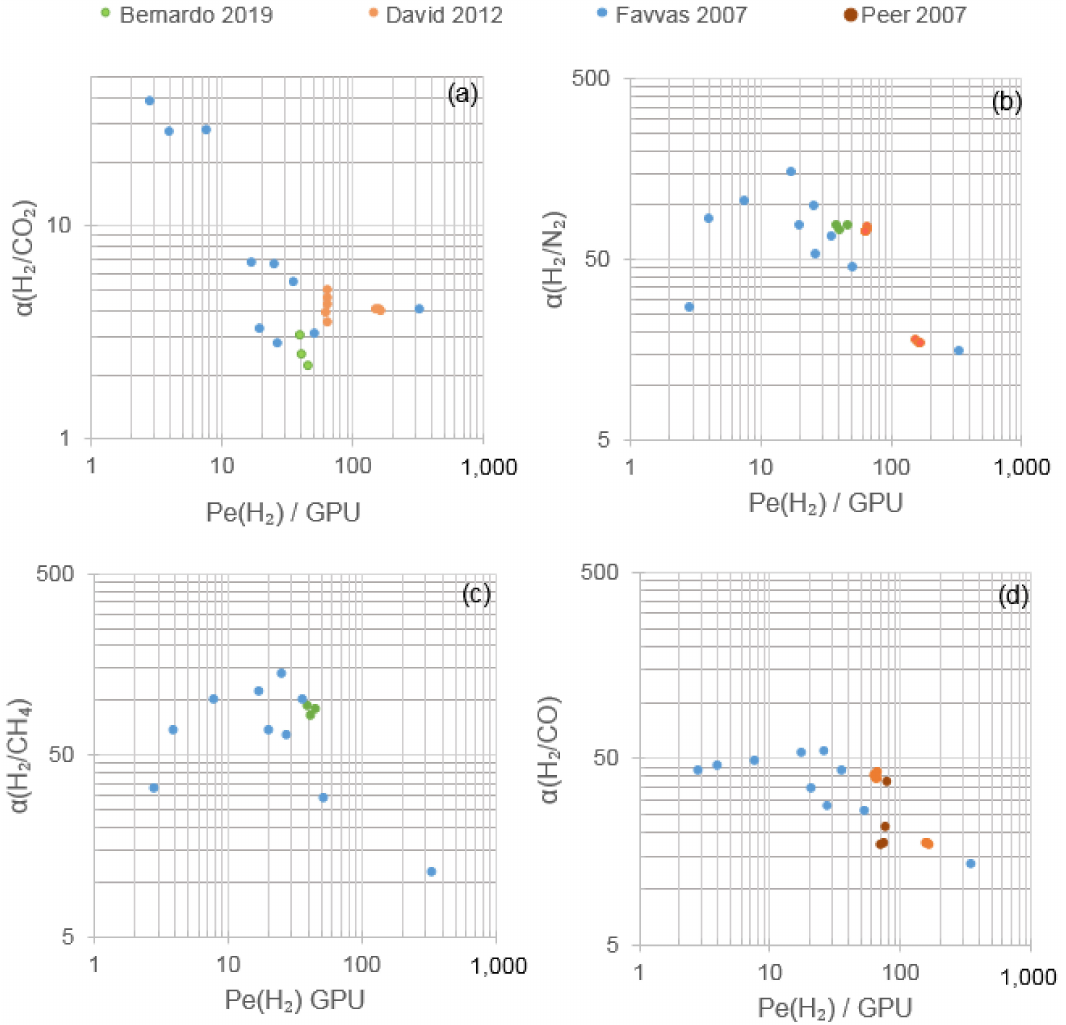
Figure 5. Hydrogen permeance values (GPU) and single gas selectivities obtained for pure Matrimid ® hollow fiber membrane (HFMs): ( a ) H 2 /CO 2 , ( b ) H 2 /N 2 , ( c ) H 2 /CH 4 and ( d ) H 2 /CO. Reference correspondence is found in Table